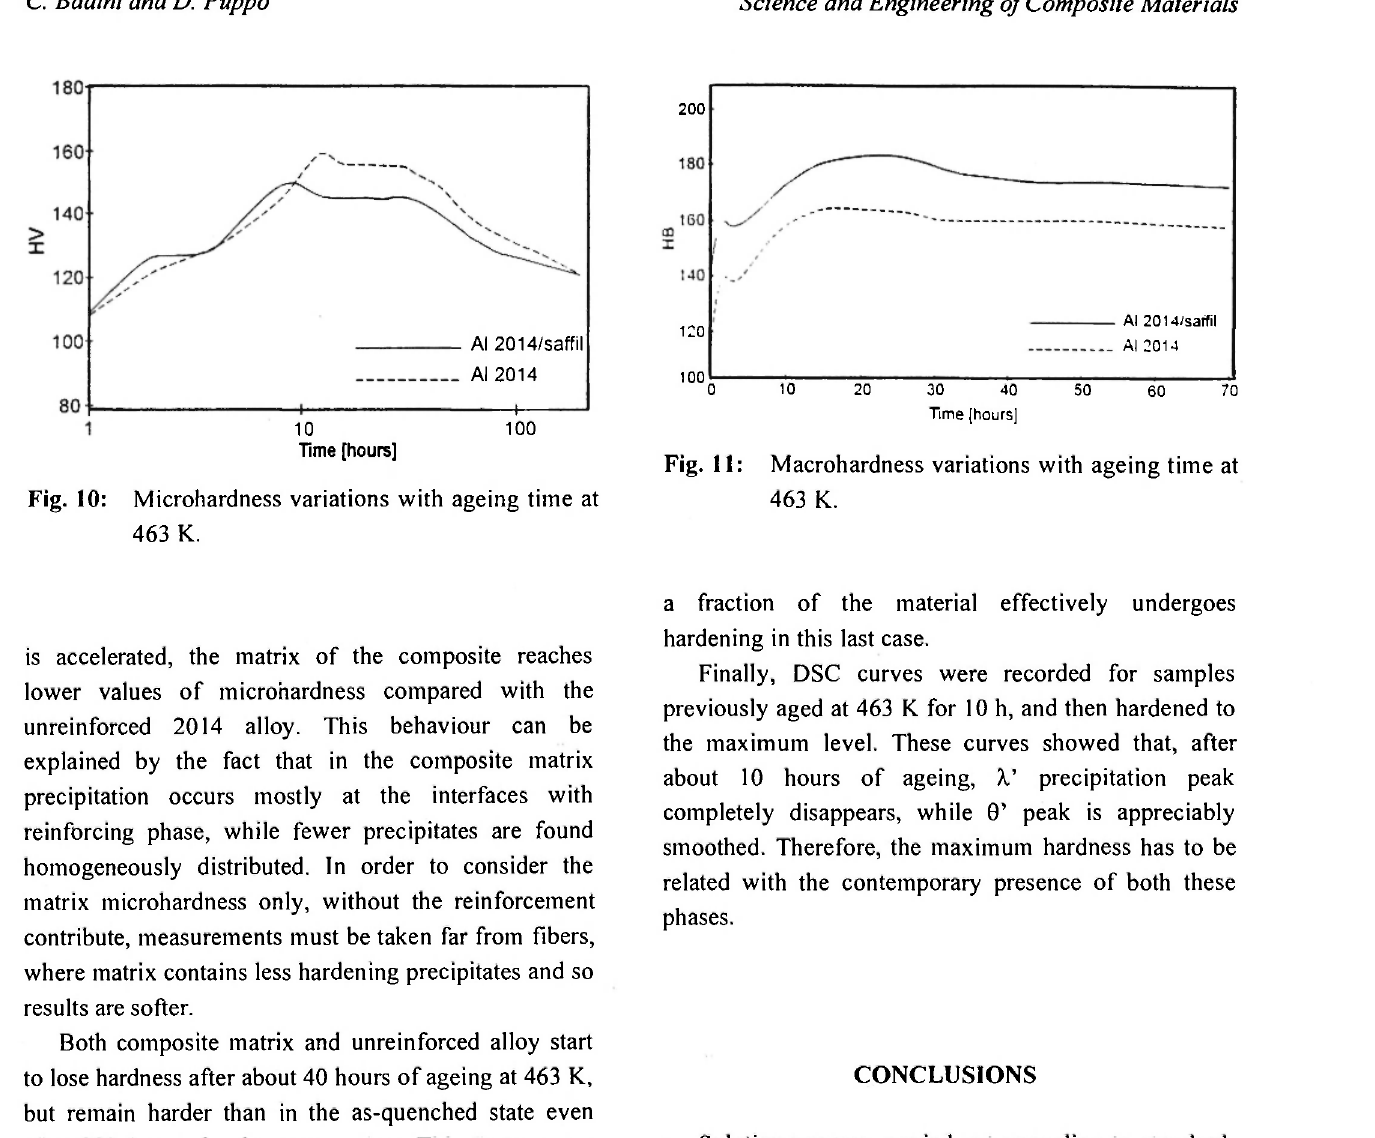
Fig. 10: Microhardness variations with ageing time at 463 K.